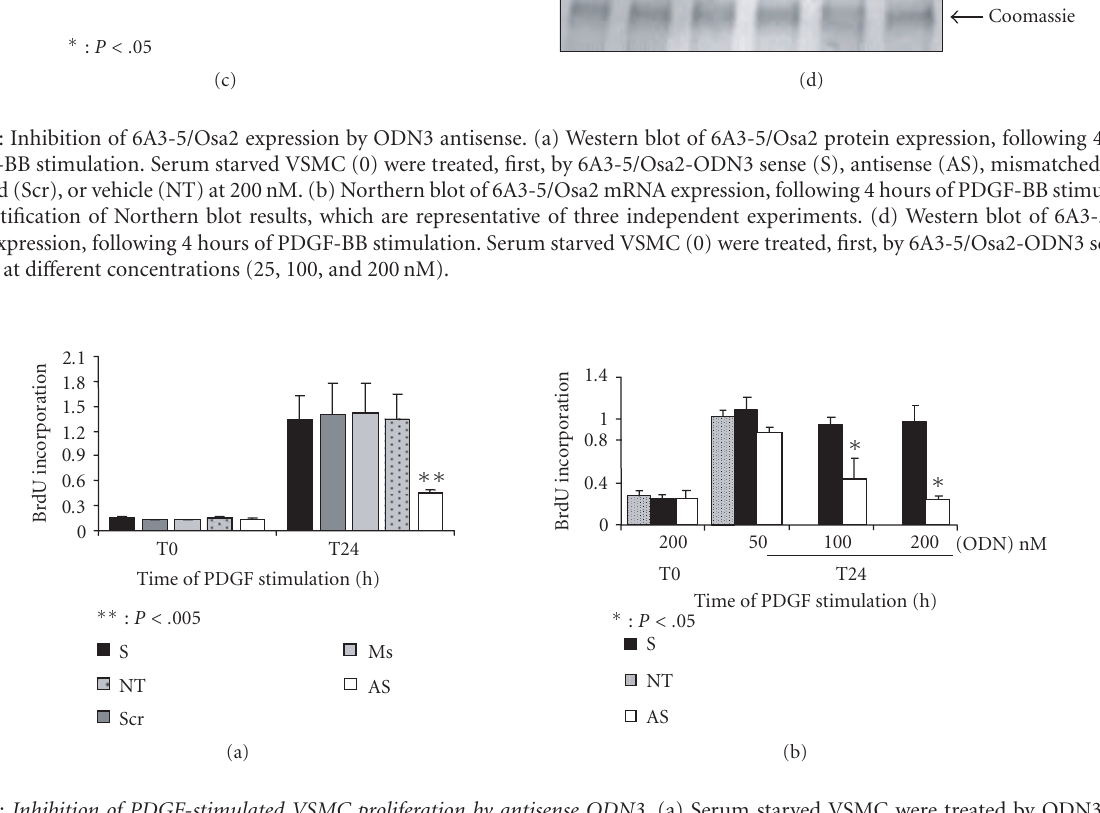
Figure 7: Inhibition of PDGF-stimulated VSMC proliferation by antisense ODN3 . (a) Serum starved VSMC were treated by ODN3 sense, antisense, mismatched, and scrambled oligos at 200nM followed by PDGF-BB (20ng/ml) stimulation for 0 or 24 hours in presence of BrdU. (b) Serum starved VSMC were treated by ODN3 sense and antisense (at 50, 100, or 200nM) following 0 and 24 hours of PDGF-BB (20ng/ml) stimulation. Untreated VSMC are used as controls of proliferation rate. The results are representative of four independent experiments. Data are presented as means ± SEM . ∗ : P < . 05 versus nontransfected cells